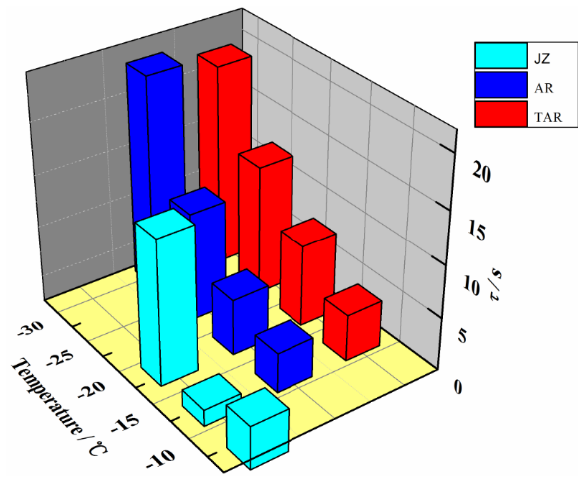
Figure 20. The variations of delay time (τ).